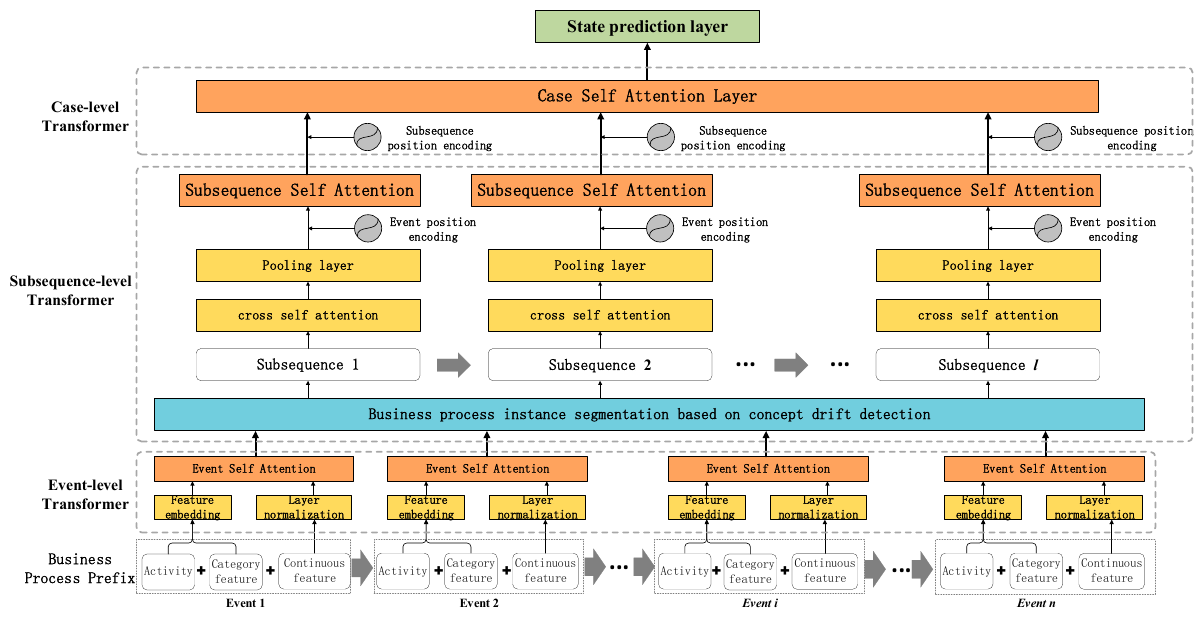
Figure 1. HiP-Transformer Model Framework.